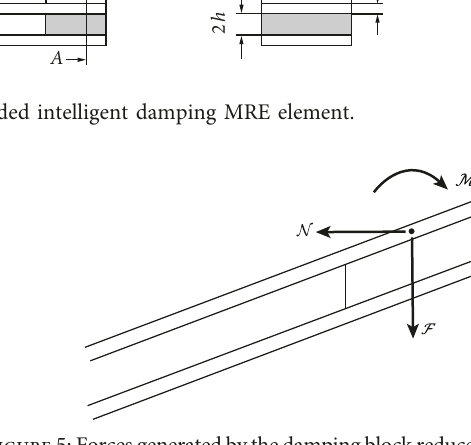
Figure 5: Forces generated by the damping block reduced to